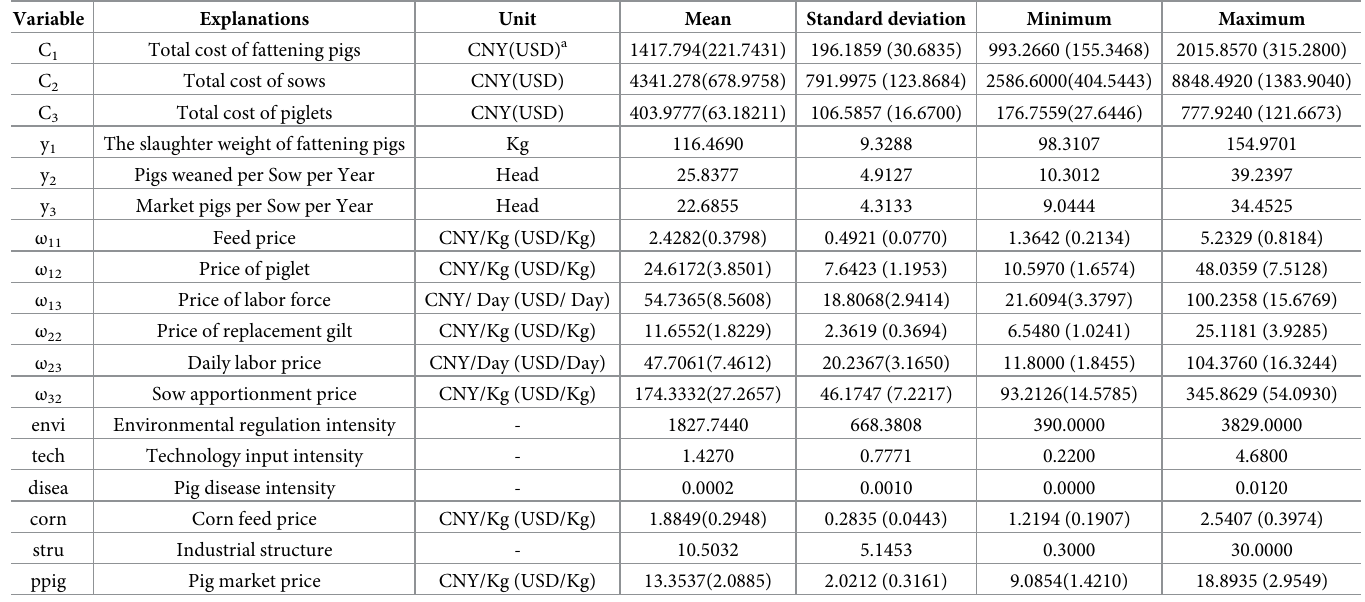
Table 3. Descriptive statistical characteristics of main